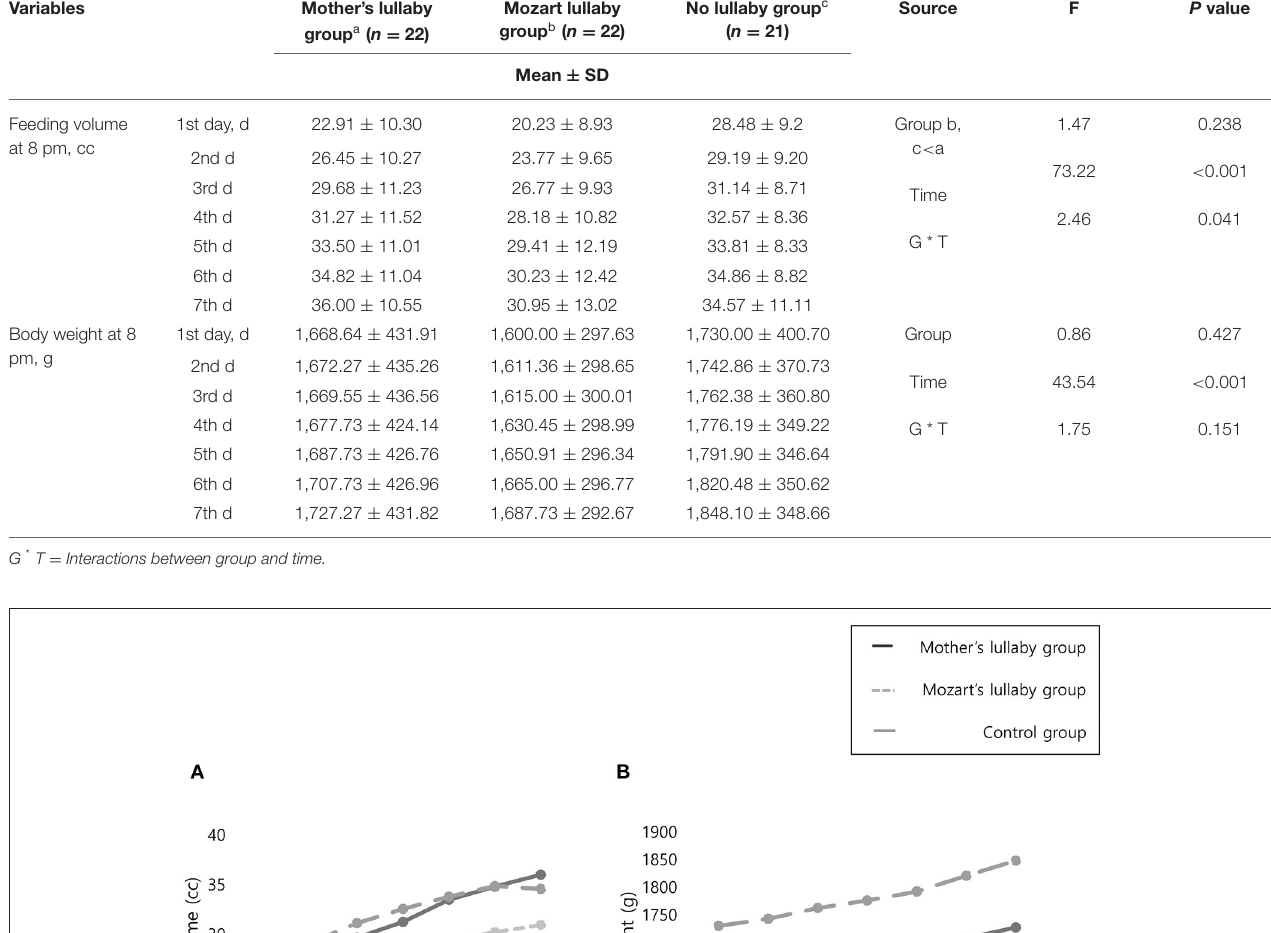
TABLE 3 | Comparison of the feeding volume and body weight between groups ( N = 65). Variables Mother’s lullaby